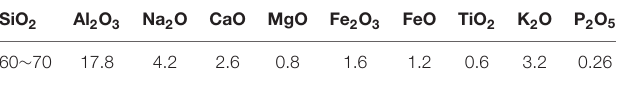
TABLE 1 | Chemical composition of natural